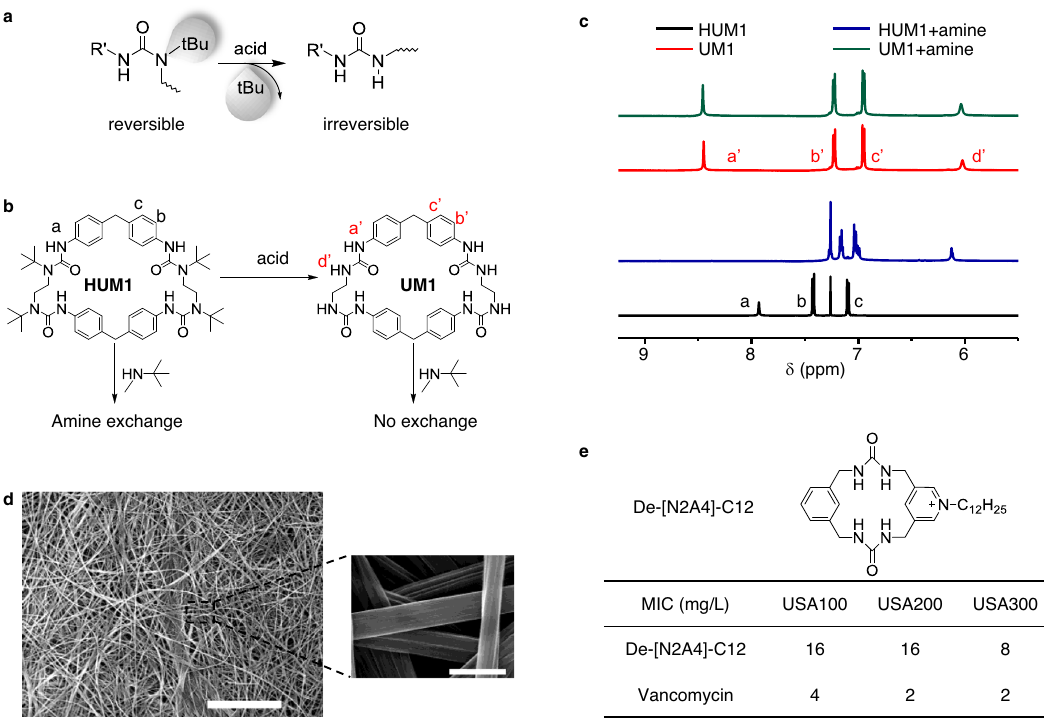
Fig. 5 Stabilization of the HUMs through de- tert -butylation and the potential applications. a Schematic illustration of the acid-assisted de- tert -butylation process. b De- tert -butylation of HUM1 gave a stable urea macrocycle UM1 , which remained unchanged with the amine exchange reaction. c 1 H NMR of HUM1 (black, in CDCl 3 ) and UM1 (red, in DMSO-d 6 ). After adding amine (10 eq) and incubated for 1 h, HUM1 was degraded (blue, in CDCl 3 ), while UM1 still remained intact (green, in DMSO-d 6 ). d SEM image of the self-assembled fi ber structure of UM1 . Scale bar: 20 μ m (zoomed: 500 nm). e MIC (minimum inhibitory concentration) of the cationic charged urea macrocycle De-[N2A4]-C12 and the antibiotic vancomycin against three different Methicillin-resistant Staphylococcus aureus bacterial